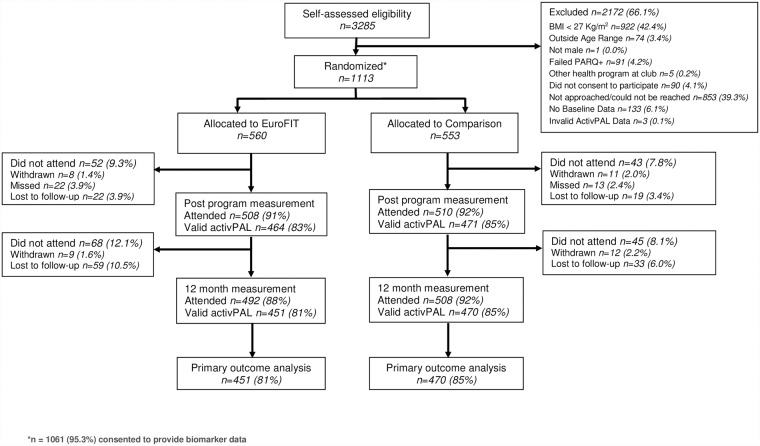
EuroFIT trial flowchart.BMI, body mass index; EuroFIT, European Fans in Training; PARQ+, Physical Activity Readiness Questionnaire-Plus.